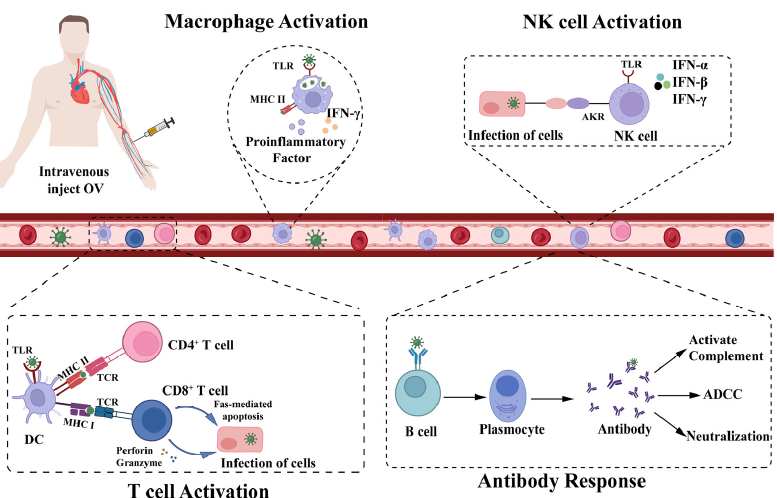
Figure 2. Immune recognition effect induced by intravenous injection of oncolytic virus (OV). When the OV is administered intravenously, the cells of the body’s immune system develop antiviral immunity. Dendritic cells (DC) present viral antigens to T cells and activate them. CD8 + T cells can play a direct toxic role in infected cells by releasing perforin and granzyme and can also cause apoptosis through the Fas pathway; B cells produce neutralizing antibodies by recognizing viral antigens to prevent re-infection of cells, and these antibodies can mediate antibody-dependent cell-mediated cytotoxic effects or activate the complement pathway to produce antiviral effects; macrophages produce large amounts of pro-inflammatory factors during the early stages of infection and phagocytose the virus through cytokinesis; after the downregulation of major histocompatibility complex (MHC) class I molecules on the surface of infected cells, natural killer (NK) cells can recognize the signal to directly kill cells, and infected cells can also activate the receptor through NK cells (AKR activates NK cells to produce pro-inflammatory factors to play a defensive role against viral infections).